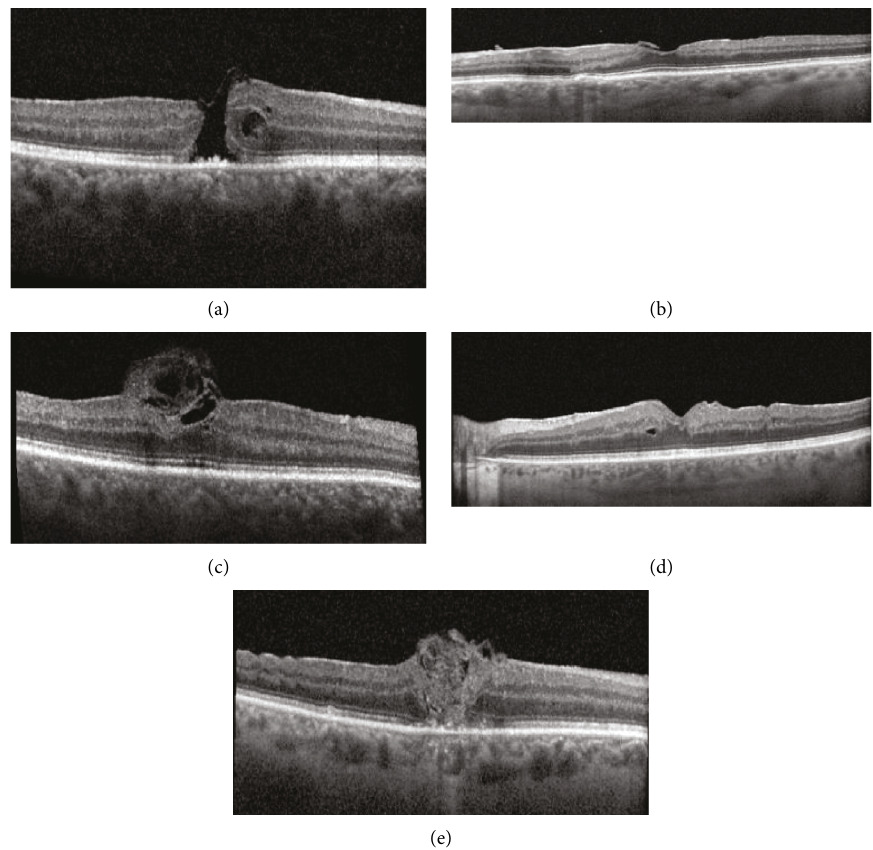
Figure 1: SD-OCTimage demonstrates the foveal contour classified as (a) flap closure, (b) U-shape, (c) W-shape, (d) V-shape, and (e) plug closure at the final